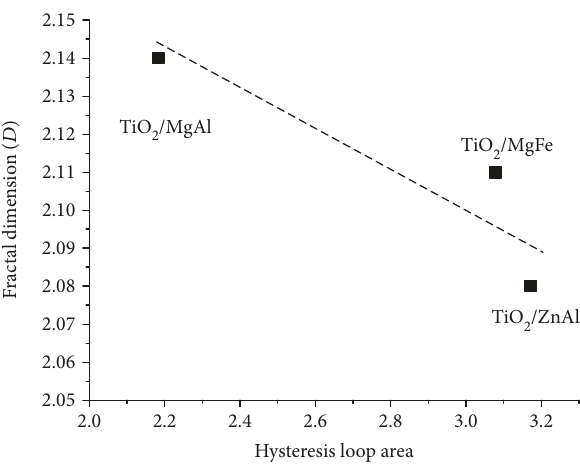
Figure 6: Relationship between pore-size distribution and fractal dimension for TiO /LDH 2